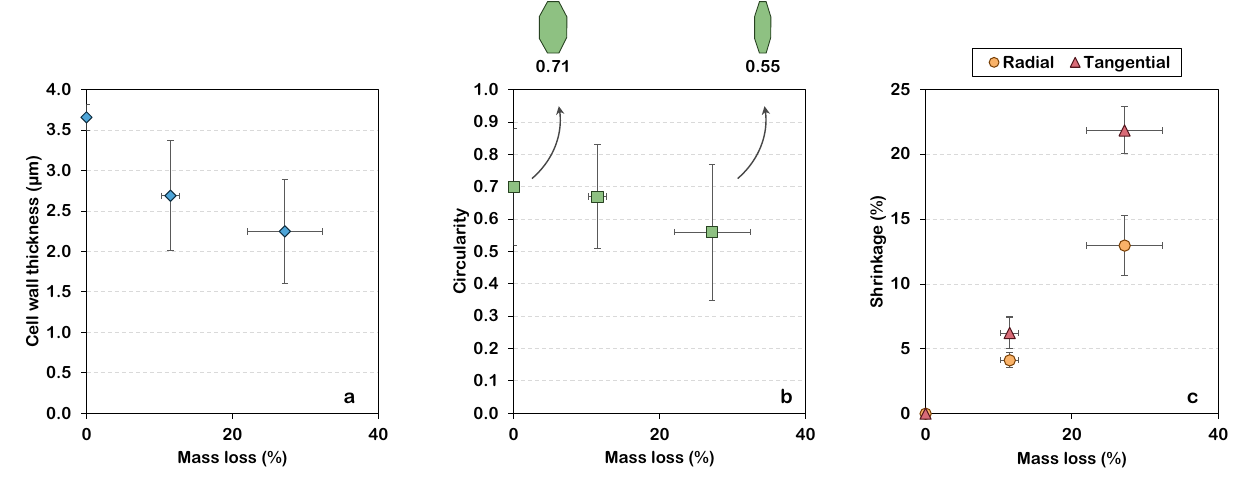
Figure 8. Morphological and physical properties as a function of mass loss. ( a ) Cell wall thickness. ( b ) Circularity, showing cells shapes presenting a circularity of 0.71 and 0.55. ( c )